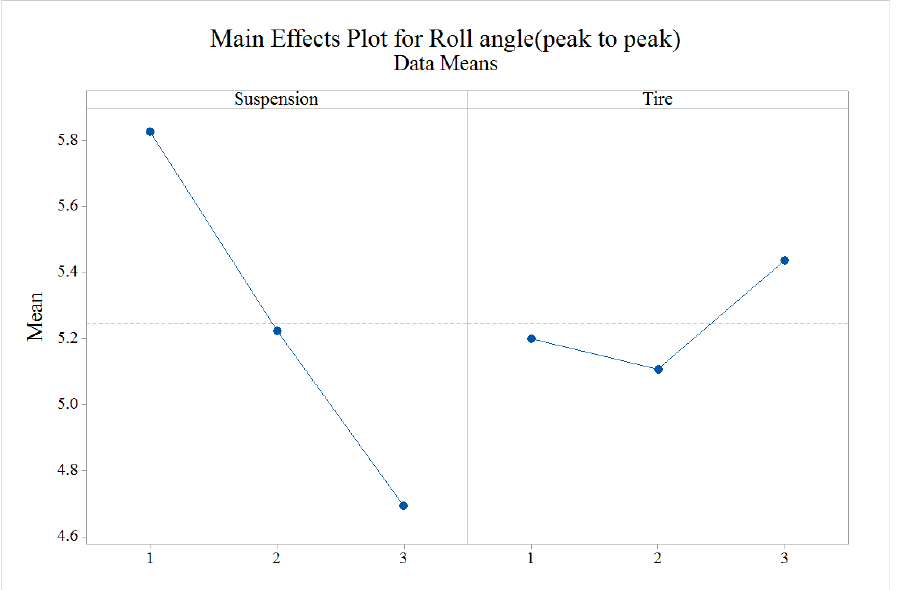
Figure 14. Suspension and tire test results (double-lane change; roll angle). Table 8. Suspension and tire test results (double-lane change; roll angle).